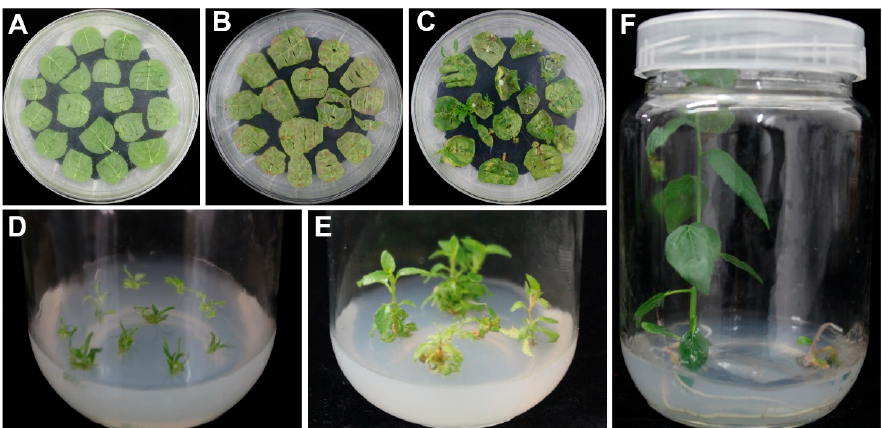
Figure 2. The flowchart of the transformation system for P. alba × P. glandulosa. ( A ) Pre-culture of leaf explants on M1. ( B ) Shoot induction of leaf explants on M3 after co-cultivated with Agrobacterium bacteria. ( C ) Shoot induction of leaf explants on M3 for 4 weeks. ( D ) Shoots cultured on M4 for root induction. ( E ) Root induction on M4 for 2 weeks. ( F ) Transgenic poplar seedlings culture on M4.